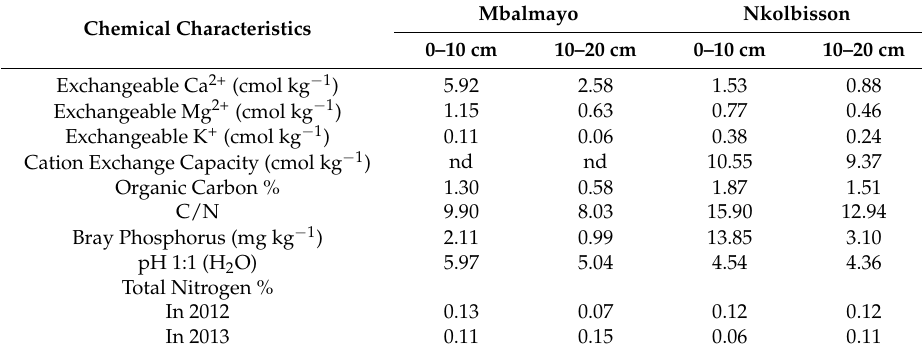
Table 3. Soil characteristics at Mbalmayo and Nkolbisson before the trials in 2012 and nitrogen level in